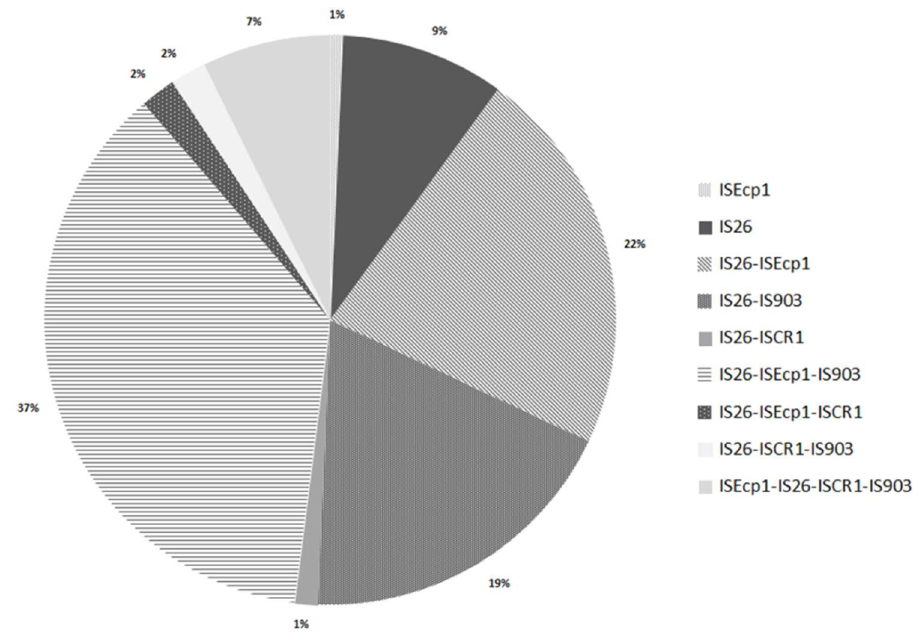
Figure 3. Genetic patterns and prevalences among the studied ESBL-producing E. coli .